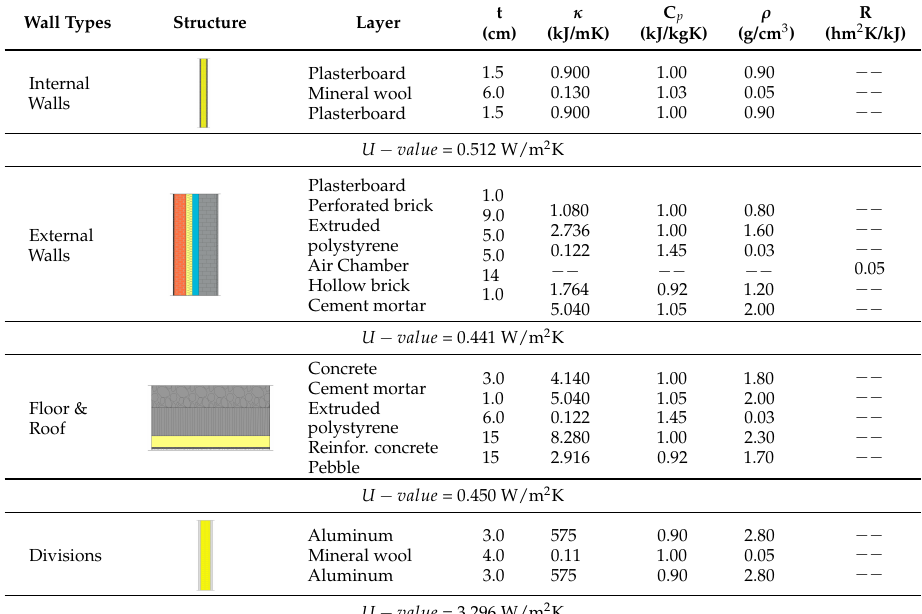
Table 2. Thermal and structural properties of adopted constructive solutions for case 2